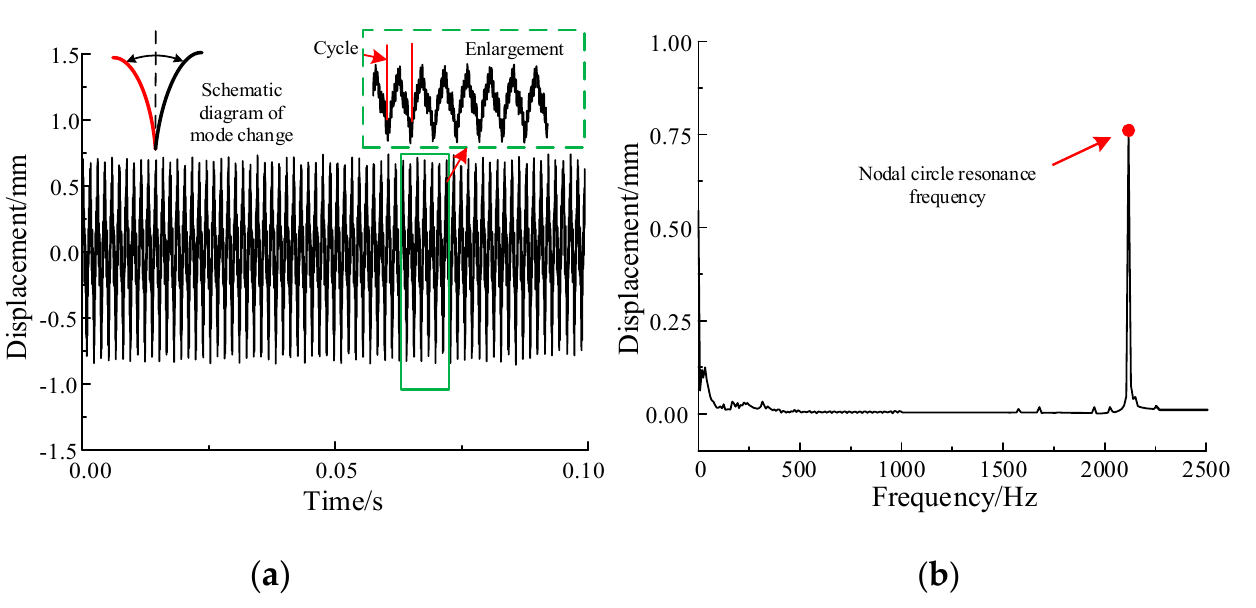
Figure 8. Radial displacement response of rim of L-shaped flexible ring gear. ( a ) Radial displacement response and ( b ) spectrum of radial displacement response.